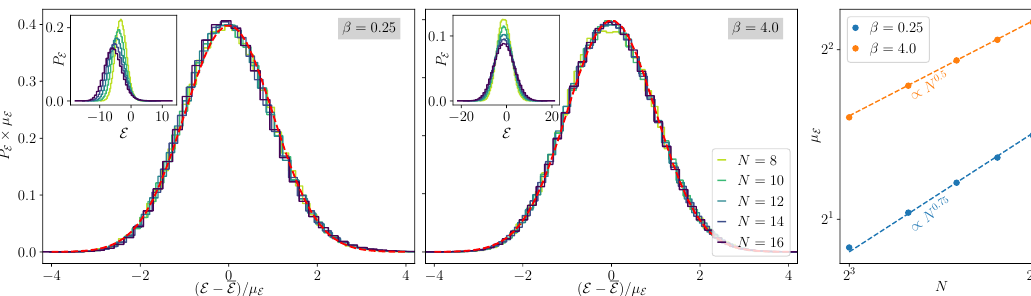
− ) /µ vs ( , E E E E . The E vs . The right panel shows µ E E